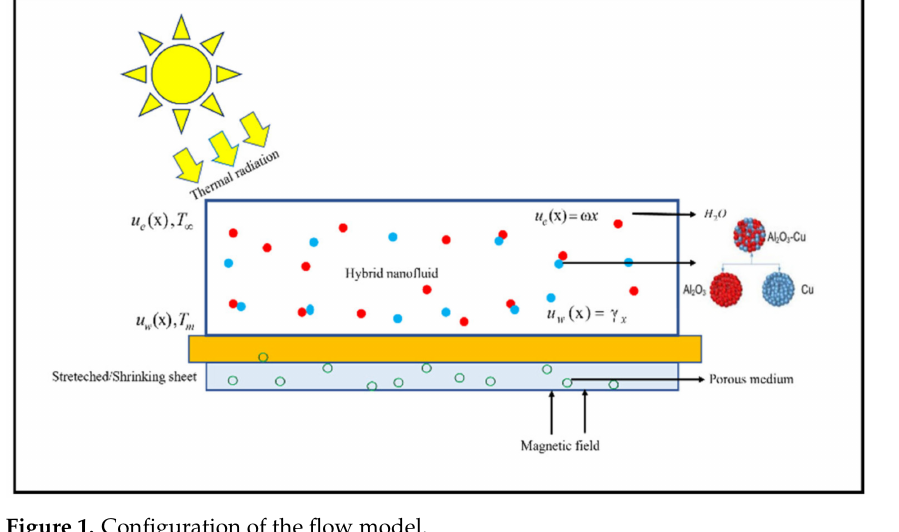
Figure 1. Configuration of the flow